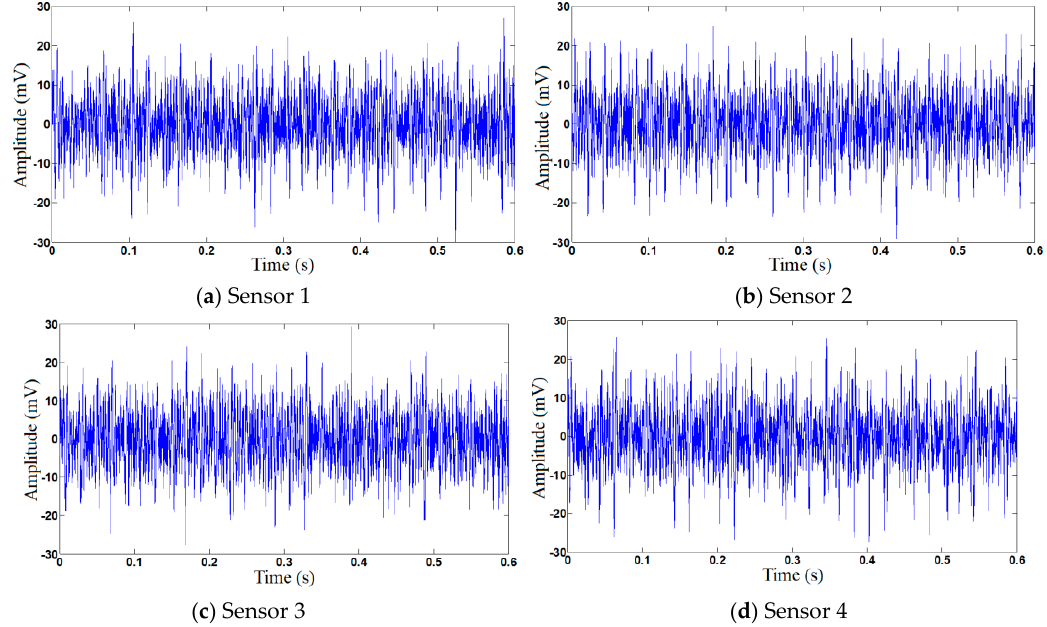
Figure 5. Time waveforms of measured vibration signals after wavelet de-noising.